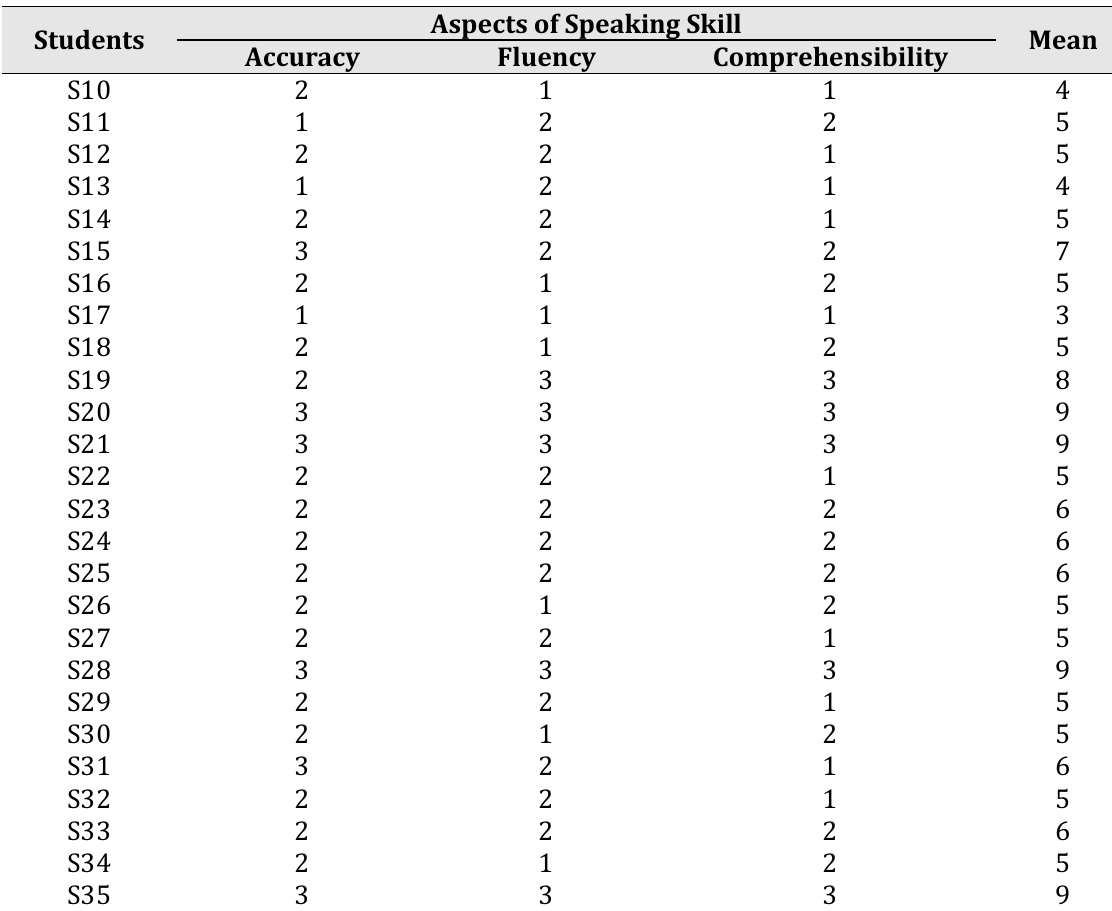
Table 6. Rate percentage point of students’ a ccuracy in pre-test result